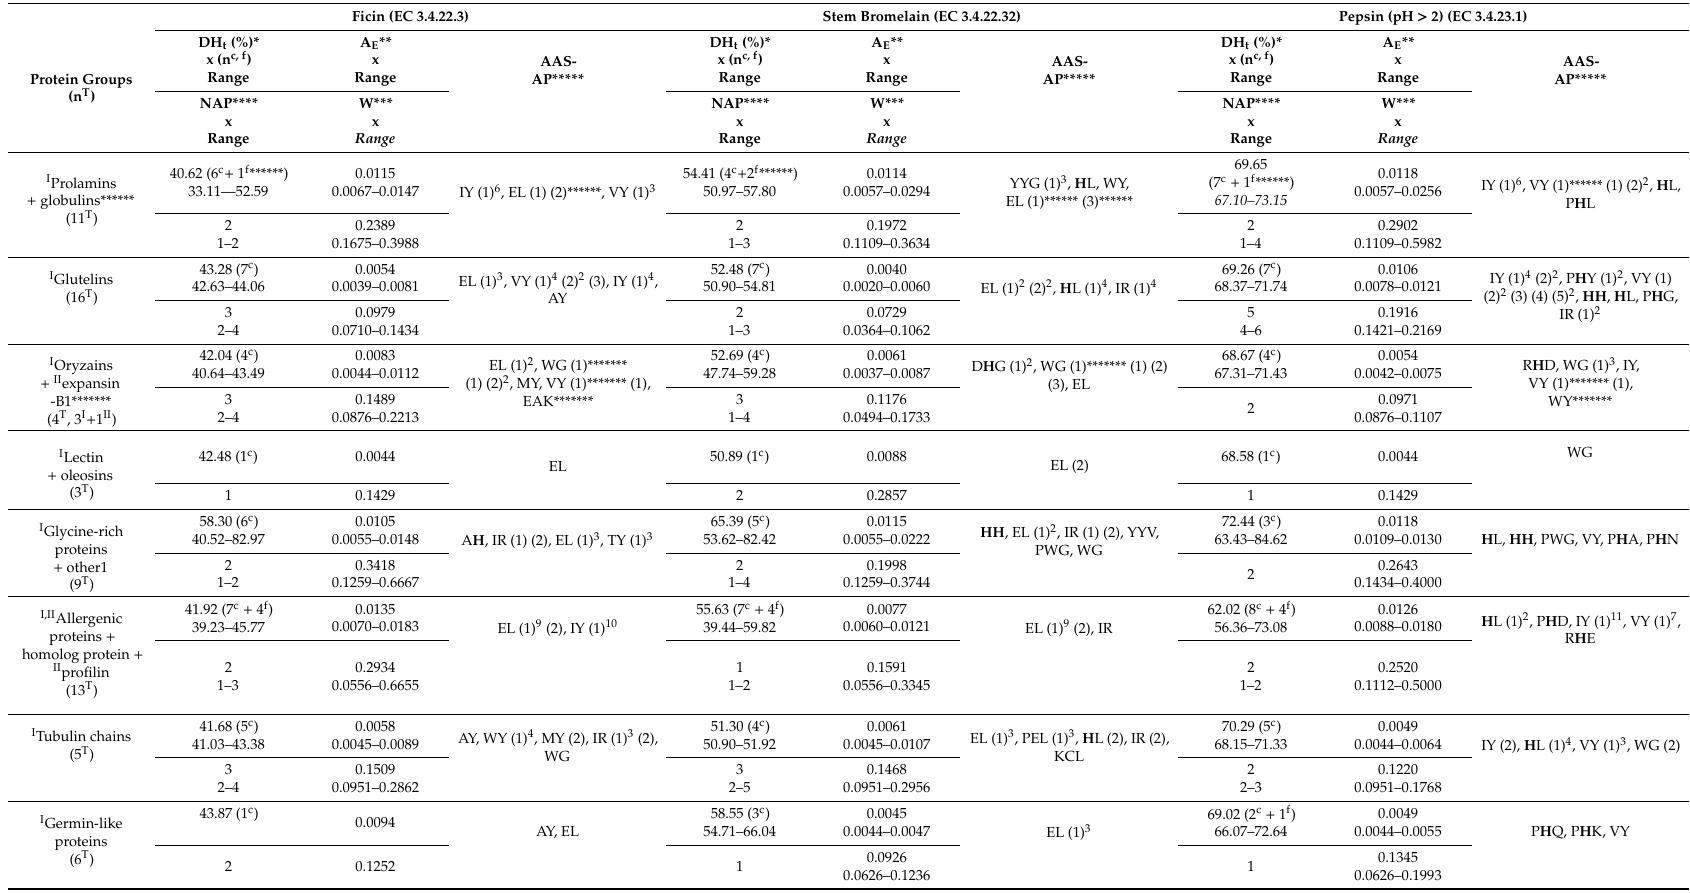
Table 7. The bioparameters characterising the in silico hydrolysis of rice proteins ( I Oryza sativa, II Oryza sativa [japonica cultivar-group], III Oryza sativa subsp. japonica ) and the molecular characterisation of the obtained antioxidant